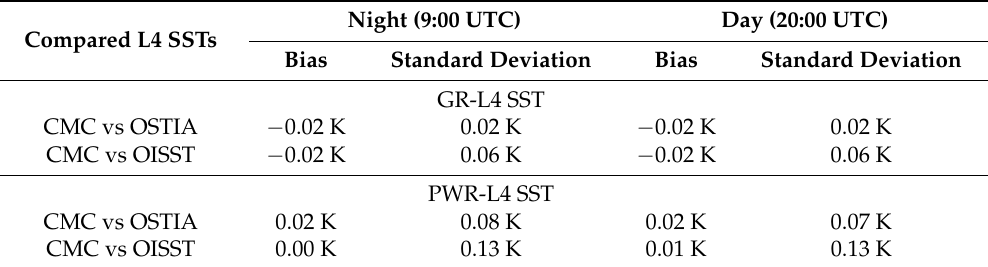
Table 6. Bias and standard deviation of variations in the GR-L4 SST and the PWR-L4 SSTs caused by training on different L4 analyses, averaged over the GOES-16 ABI clear-sky SST domains